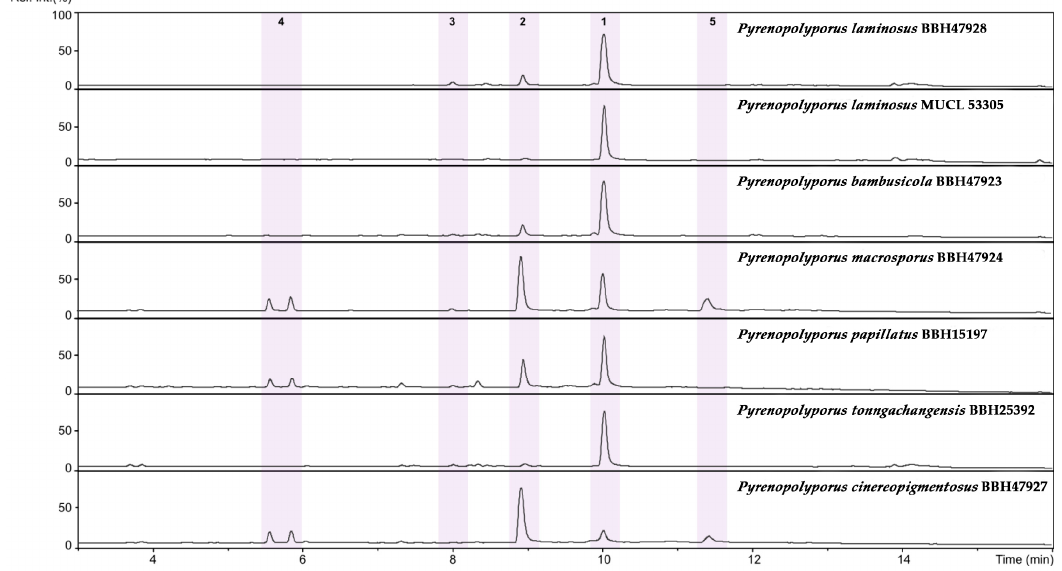
Figure 18. HPLC–UV/vis chromatograms (210 nm) of stromatal extracts of the evaluated Pyrenopolyporus spp. in this study. 1 : Hypoxylone [M + H] + : 333.07588 Da; C 20 H 12 O 5 ; 2 : BNT [M + H] +